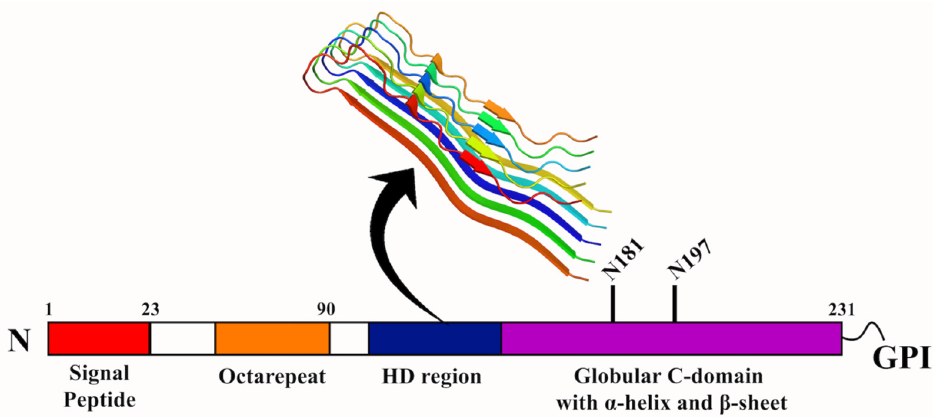
Figure 6. Domain structure of PrP protein. The signal peptide that guides the PrP protein is represented in red, with the octapeptide in orange. The globular C-terminal domain (CTD) with α -helices and β -sheets are shown in purple. The hydrophobic domain (HD) between the octapeptide and the CTD is colored in blue. The fibril form of human PrP is shown at the top (PDB ID: 6UUR) [126]. Transmissible spongiform encephalopathy (TSE) is another fatal neurodegenerative disorder caused by PrP c . The disorder results from the misfolding of PrP c to its scrapie isoform PrP sc . The PrP sc isoform is insoluble, partially protease-resistant, and can propagate by interacting with the normal isoform PrP c . PrP sc has a strong polymerizing tendency, and as a result, it forms amyloid aggregates. These aggregates are usually observed to be accumulated in the brain [120]. The accumulation is generally observed in the lymphoretic- ular region and brain, and the effect is typically neuronal vacuolation and death.